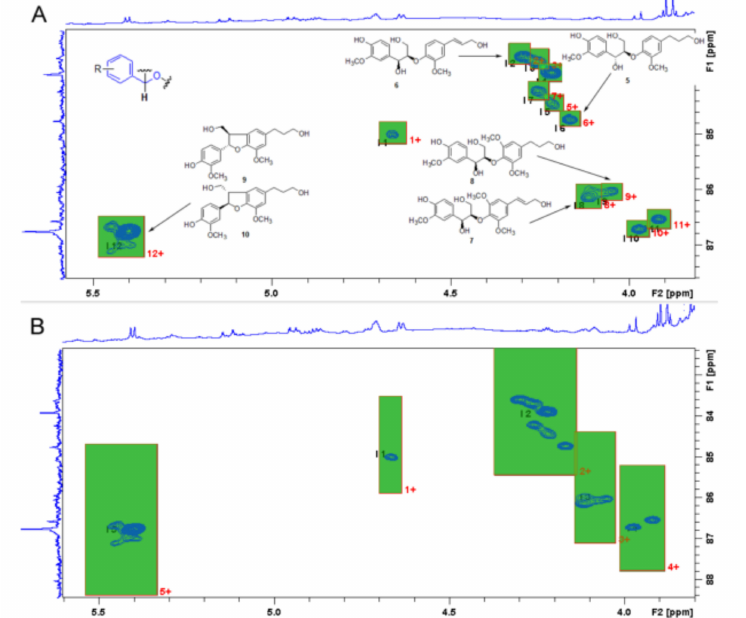
Figure 1. Integral region chosen for active lignan quantitation in SWCA in the 13 C-NMR spectrum between 80 and 90 ppm using the selective HSQC spectrum. ( A ) Integrating spectra with 12 regions; ( B ) integrating spectra with five regions. Names of the represented compounds are as